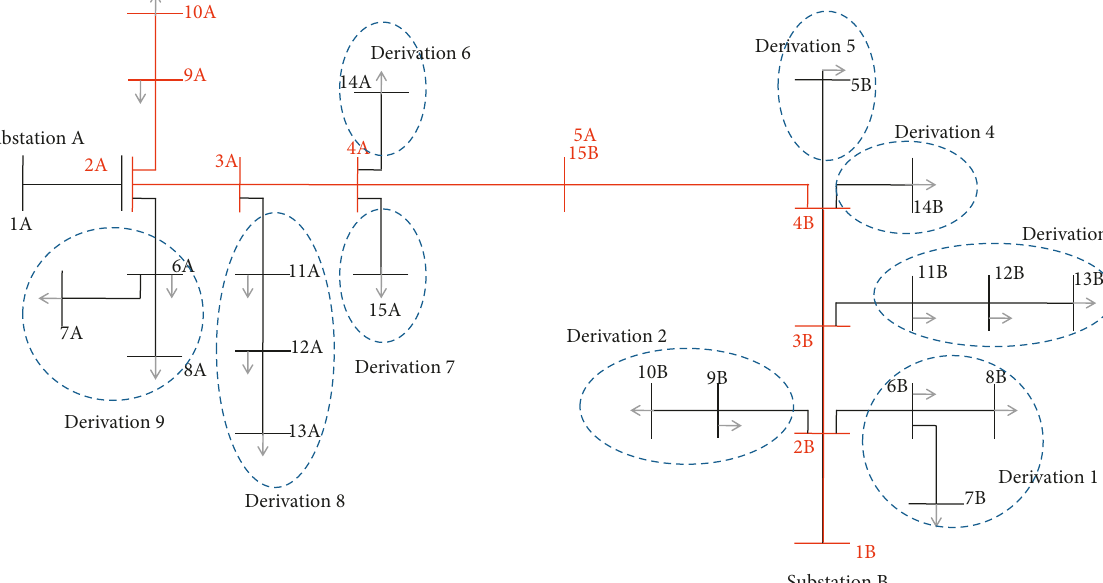
Figure 11: The element ordering of the topology structure presented in Figure 10.